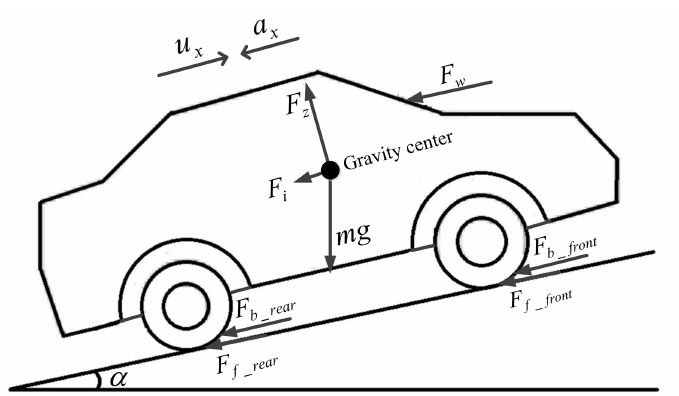
Figure 5. Scheme of the vehicle longitudinal dynamics. The vehicle longitudinal dynamics of Equation (1) already include the wheel rotational dynamics so the braking force of each wheel can be expressed by Equation (2).